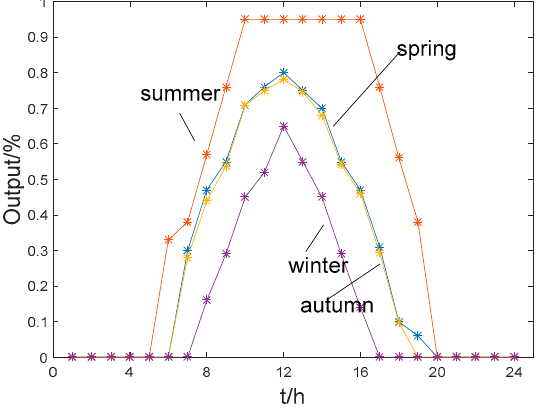
Figure 2. Photovoltaics (PV) timing characteristics curve.